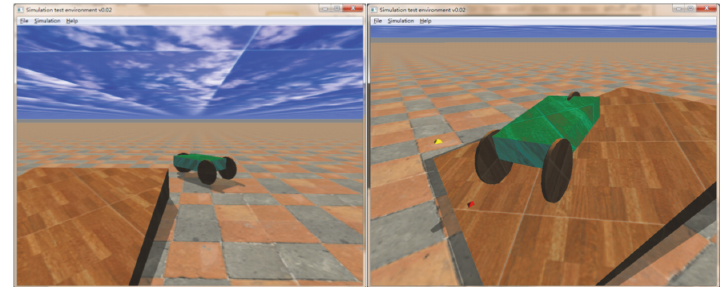
Figure 4: Turning and climbing of the vehicle model.